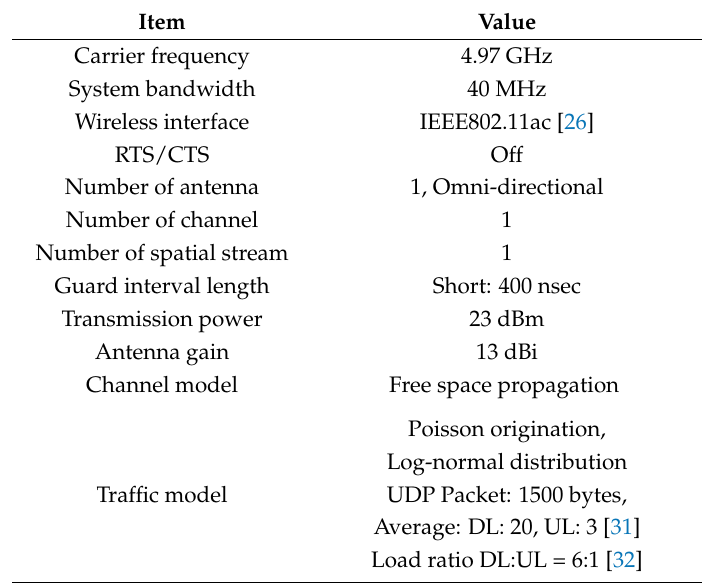
Table 1. Simulation parameters.